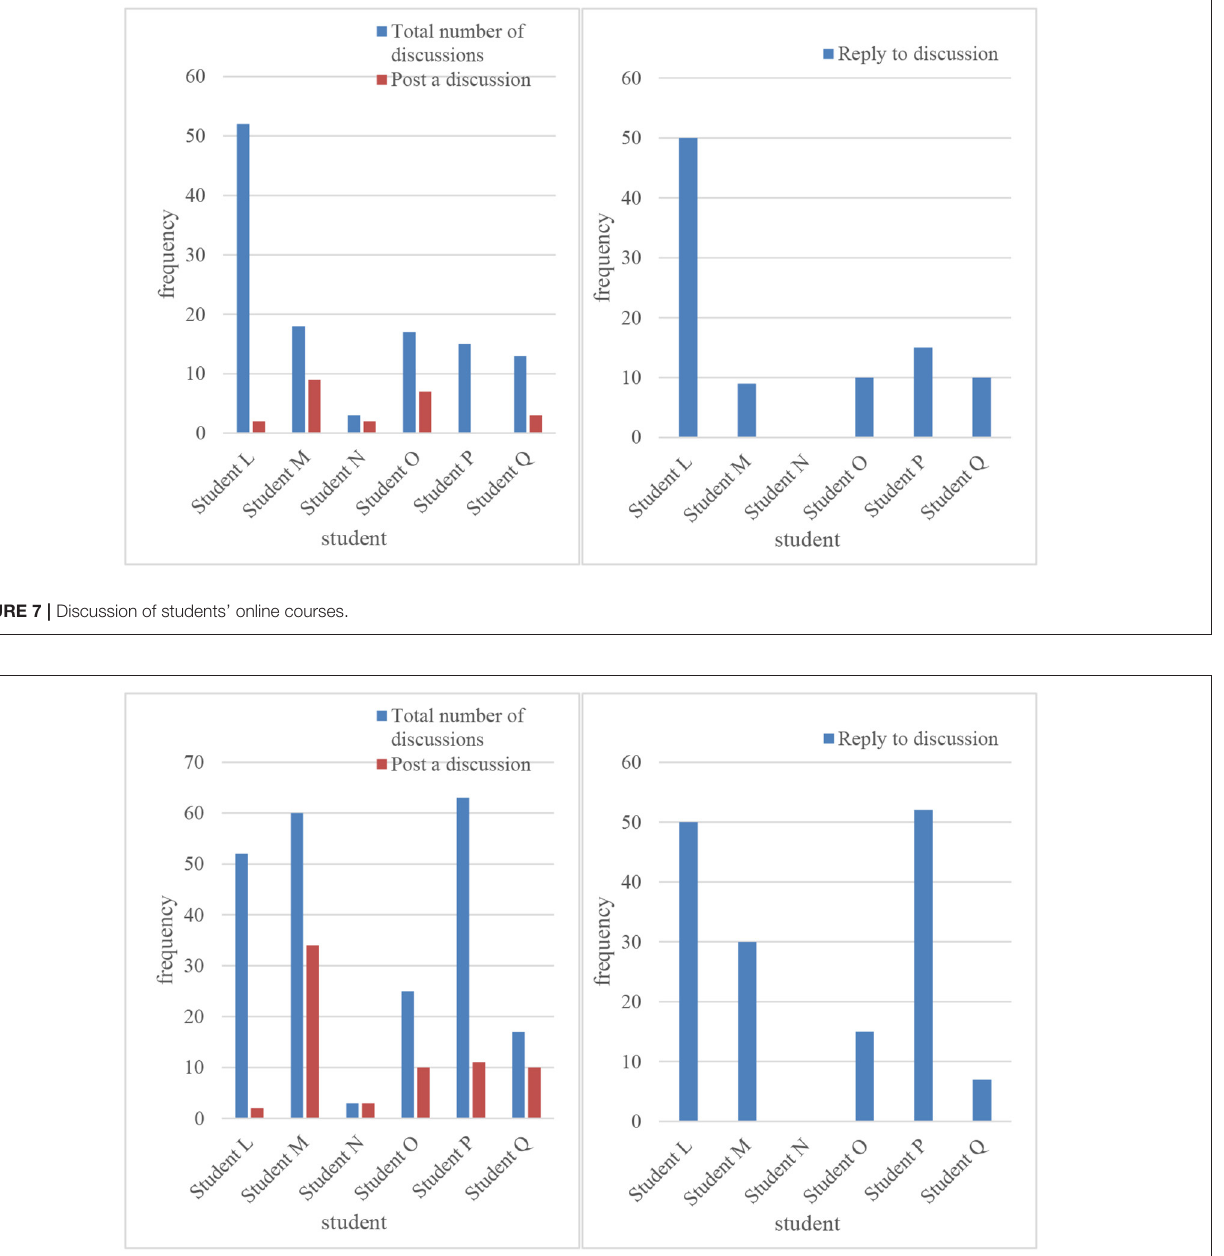
FIGURE 8 | Comparison of the number of student